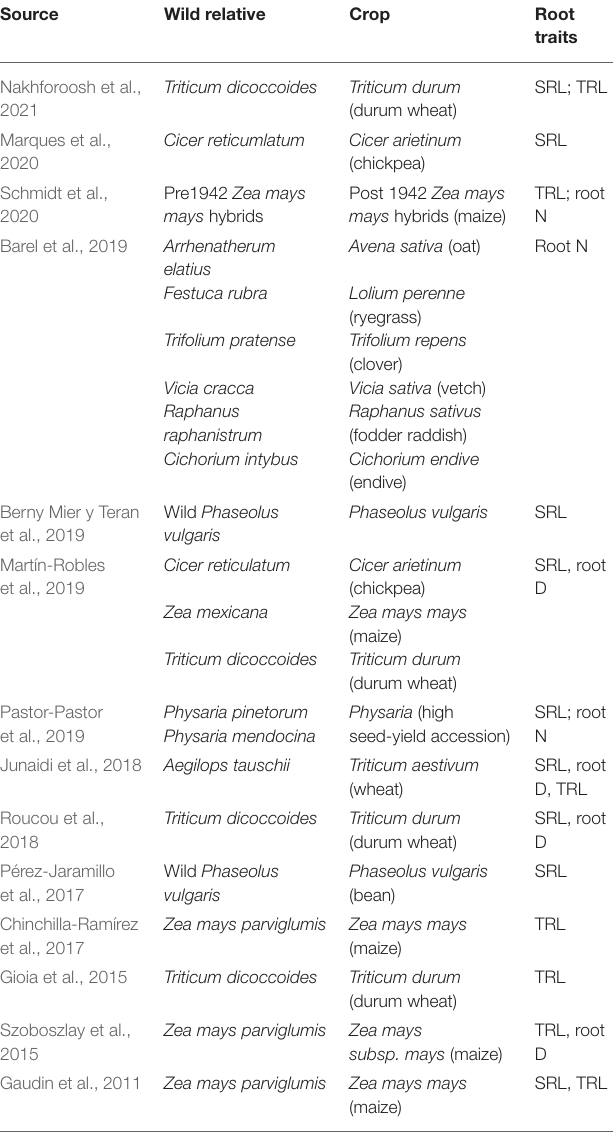
TABLE 1 | Sources identified through a systematic literature review, with associated wild relative, crop and suite of root traits in each source.